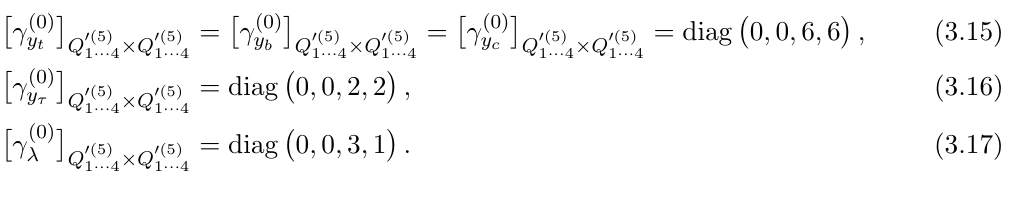
; Q 0 (5) operators at one loop, with only one representative 3 4